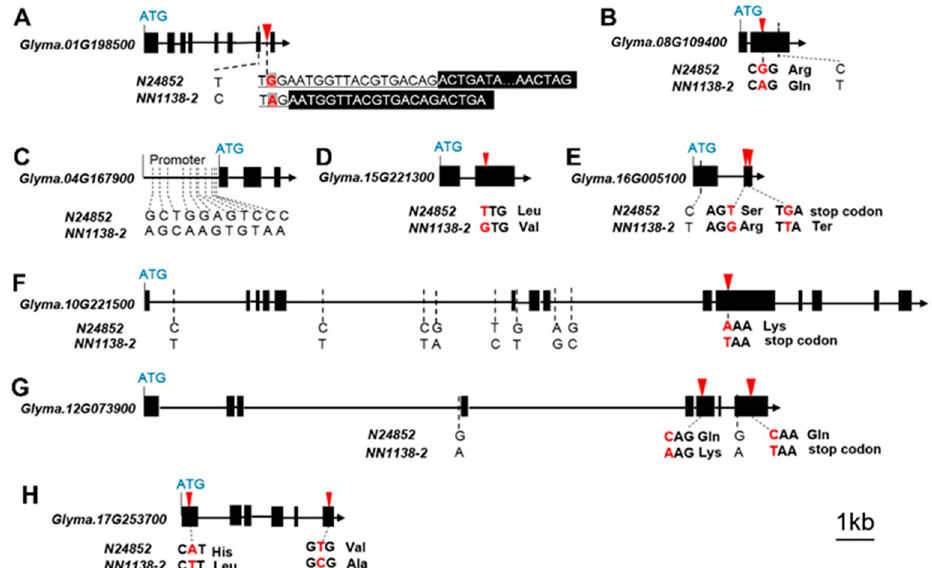
Figure 4. Sequence analysis of SCC and DTF candidate genes between N24852 and NN1138-2 . ( A ) and ( B ), are candidate genes of SCC, respectively; ( C – H ) are respective DTF candidate genes. The black boxes represent exons; the lines between boxes represent introns; red arrowheads and broken lines represent the variant position. Red nucleotides represent SNP between N24852 and NN1138-2, which are nonsynonymous mutations and marked with red arrowheads. Table 3. Expression patterns of candidate genes related to SCC and DTF.